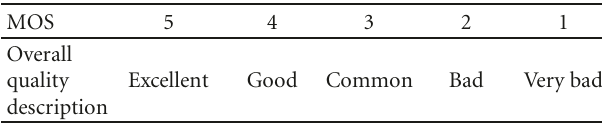
Table 9: MOS score category description-ACR